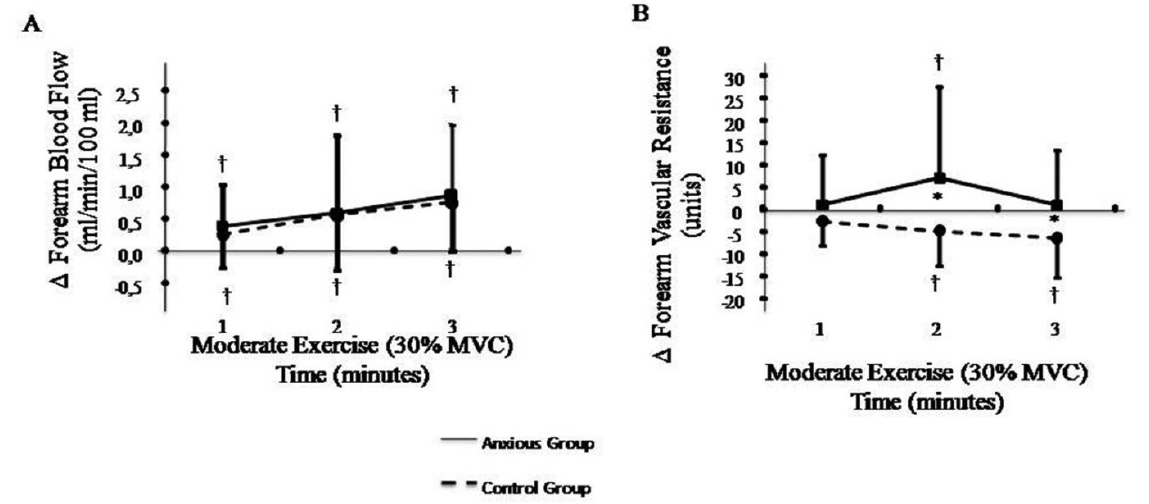
Figure 2. Absolute delta values of the forearm blood flow (ml/min/100 ml) and forearm vascular resistance (units) responses during the exercise protocol at 30% of maximal voluntary contraction (panels A and B, respectively). Note that muscle blood flow increased significantly and similarly in both groups (panel A); however, forearm vascular resistance decreased in the control group and increased in the anxious group, becoming greater in the anxious group (panel B). Ip≤0.05 vs. baseline; *p≤0.05 vs.